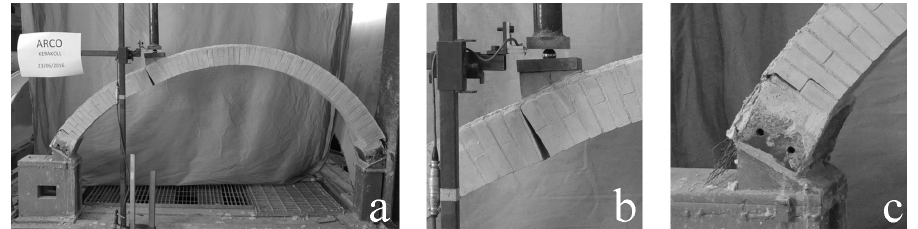
Figure 4. Basalt-FRLM-strengthened arch: ( a ) collapse mechanism; ( b ) opening of hinge 1; ( c ) opening of hinge 4. Buildings 2017 , 7 , 49